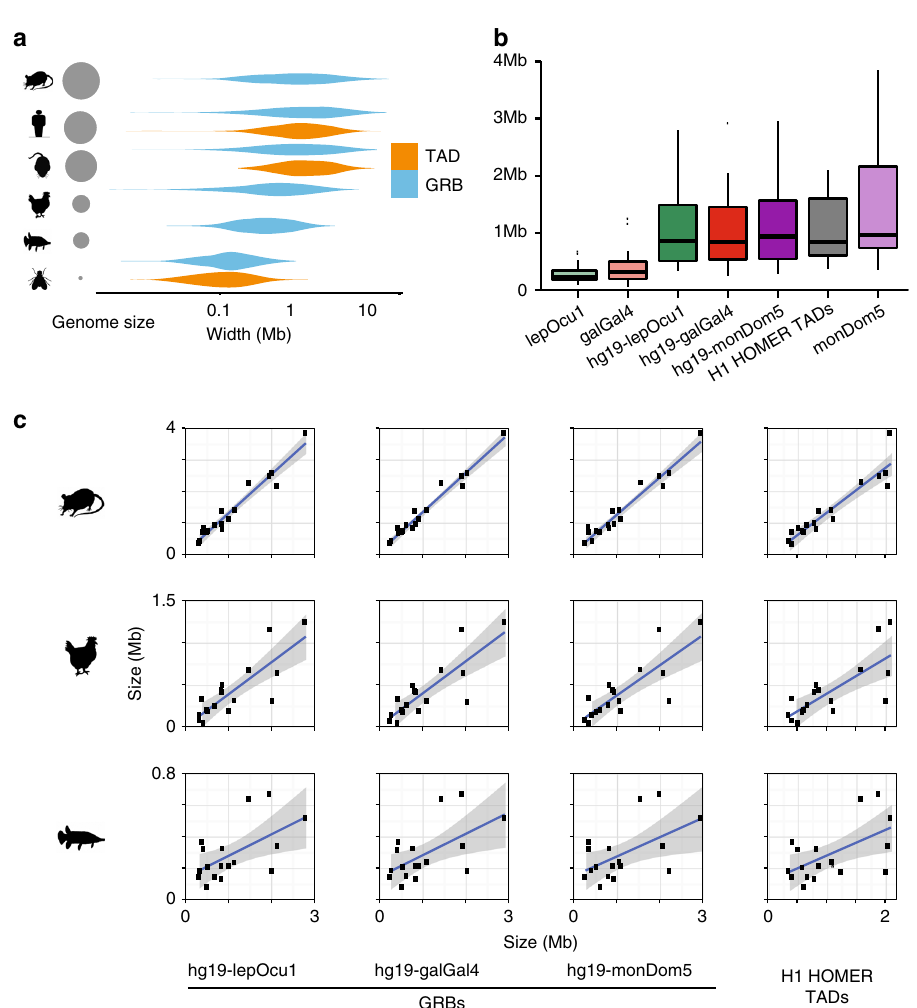
Fig. 5 The span of CNEs in various species is predictive of genome size and TAD size. a Distribution of genome size, TAD size and GRB size in opossum, humans, mouse, chicken, spotted gar and Drosophila . b Sizes of 17 stringent GRBs identi fi ed in various species shows direct expansion and growth in line with that expected given differences in genome size. c Correlation of sizes of GRBs identi fi ed in one species compared to other species and to the corresponding TADs in humans fi nds that the size of a GRB identi fi ed in other species is highly predictive of the size and scope of regulatory domains in other